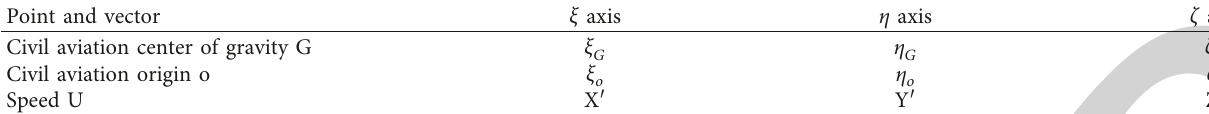
Table 1: Main symbols of the fixed coordinate system.